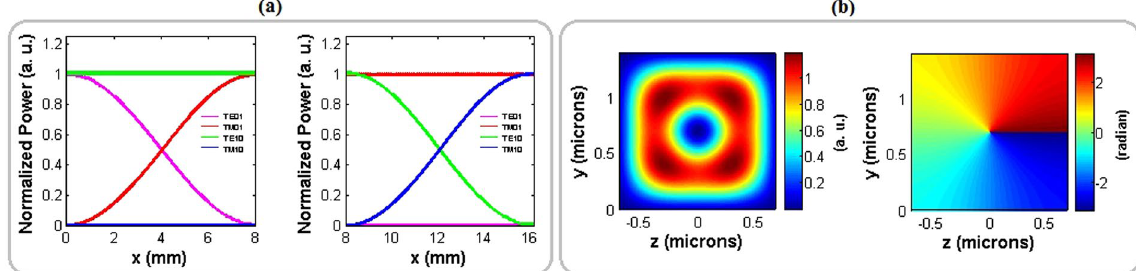
Figure 6. ( a ) Normalized power evolution of all interacting | TE 01 〉 (magenta), | TM 01 〉 (red), | TE 10 〉 (green) and | TM 10 〉 (blue) modes along the polarization converter part of the modulator for two successive sections with domain wavelengths Λ 01 (left) and Λ 10 (right); and ( b ) Power and phase of the emitted vertically polarized OAM carrying beams after applying external electric field.